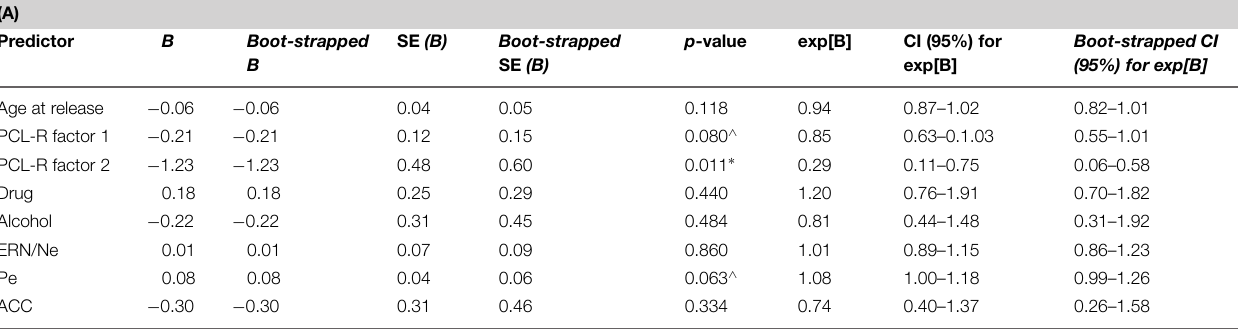
TABLE 5 | Cox regression with ERP, fMRI, and covariates predicting rearrest ( N =